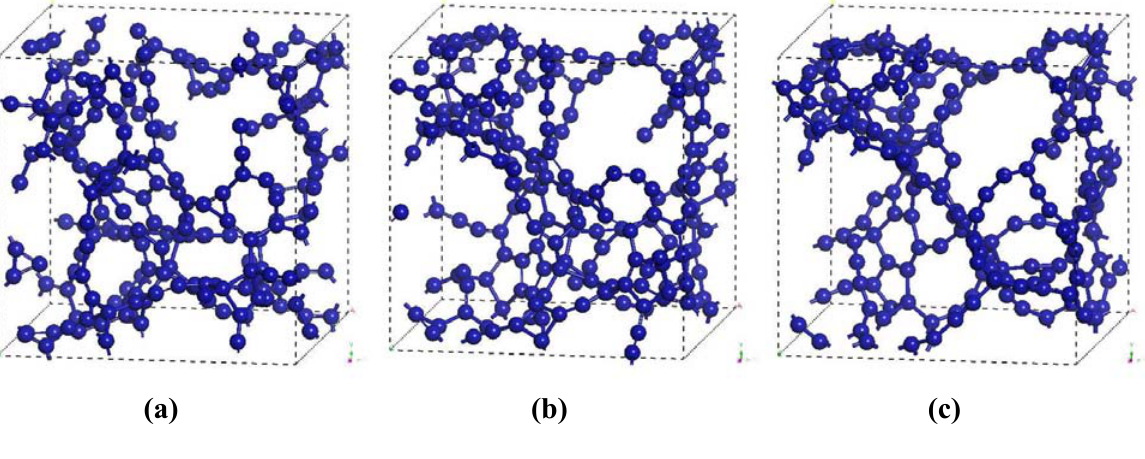
Figure 4. Evolution of the atomic structure of carbon with 61.1% porosity as a function of the number of simulation steps. Optimized structures are shown for (a) 100, (b) 200 and (c) 295 simulation